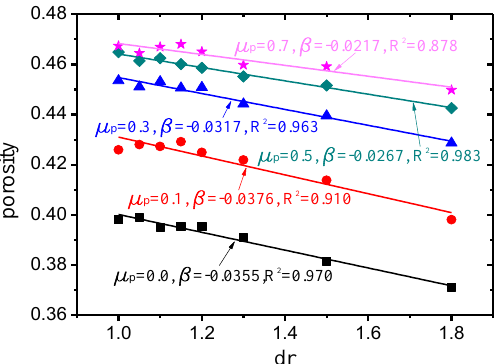
Figure 6. β values of different friction coefficients obtained by bi-dispersed packing.